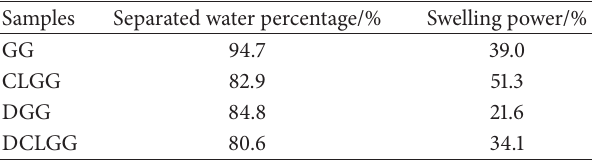
Figure 4: Mutual effect of reaction time and pH at fixed reaction temperature of 40 ∘ C and amount of ethanol of 74.5%.